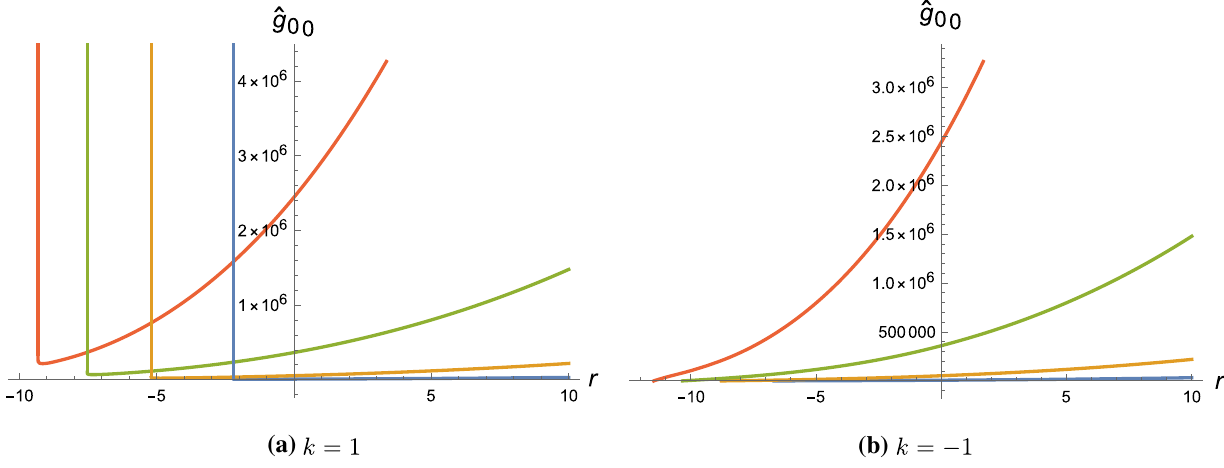
Fig. 37 Profiles of the ten-dimensional metric component ˆ g 00 for the supersymmetric flows given in Figs. 35 and